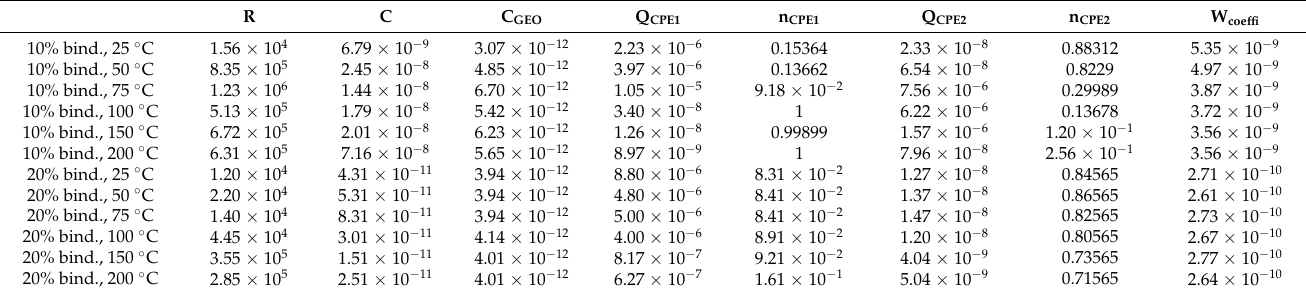
Table 2. Equivalent circuit fitted